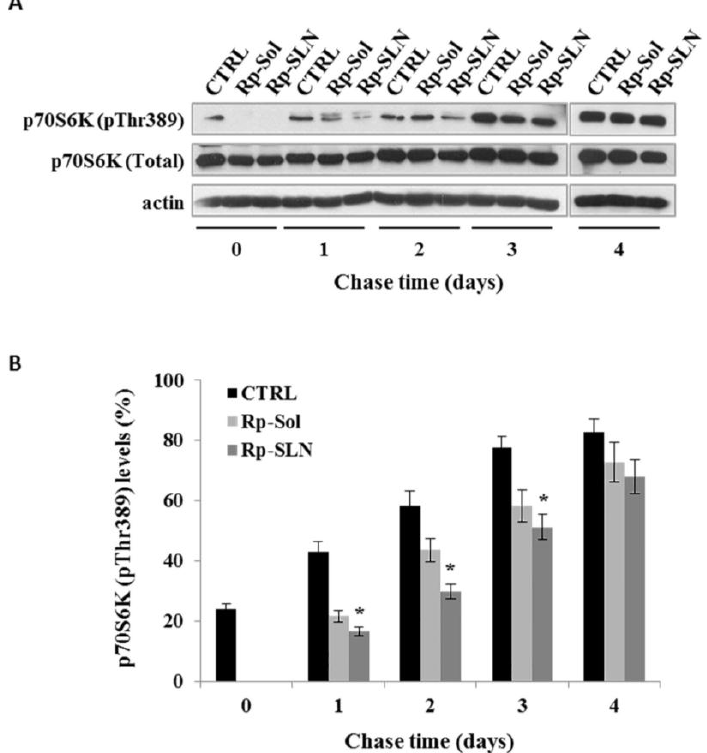
Figure 10. Effect of Rp-SLN on mammalian target of rapamycin (mTOR) activity. The SH-SY5Y cells were seeded in a 6-well plate, incubated overnight at 37 °C and then treated for 4 h with 20 nM of Rp-sol or Rp-SLN (Pulse); untreated cells were considered as control (CTRL). ( A ) Cells were recovered after 0, 1, 2, 3 and 4 days (chase) and the immunoblotting analysis was performed for phospho-p70S6K (pThr389), p70S6K (Total) and actin. Representative Western blotting of three independent experiments is reported; ( B ) densitometric analysis of the immunoblot represents the percentage of the ratio between phospho-p70S6K (pThr389) with respect to p70S6K. Values are the mean ± S.D. of three independent experiments. * p < 0.01 (Rp-SLN vs. CTRL cells) according to unpaired two tailed Student’s t -test.